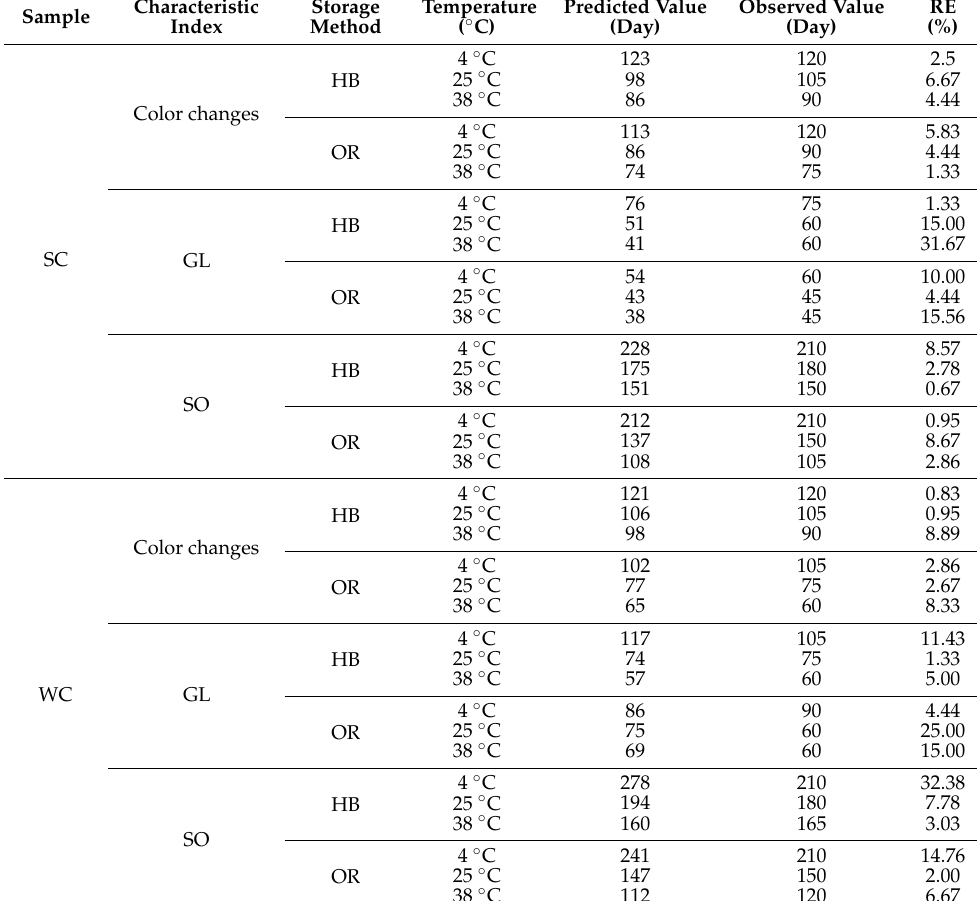
Table 2. The validation results of the shelf-life prediction models based on the characteristic indexes of the fresh corn